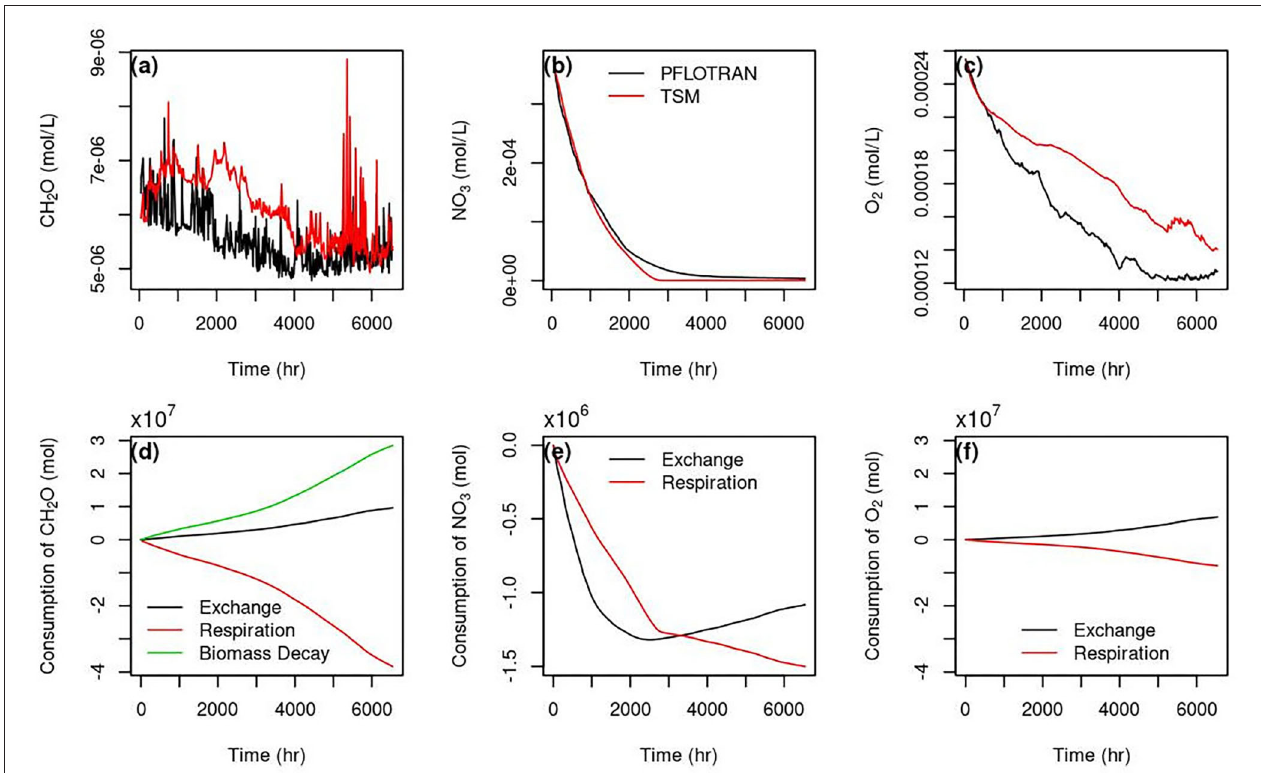
FIGURE 7 | Temporal concentration curves of CH 2 O (a) , NO 3 (b) , and O 2 (c) simulated using PFLOTRAN and TSM, and the total consumption (negative) of CH 2 O (d) , NO 3 (e) , and O 2 (f) by different processes simulated using